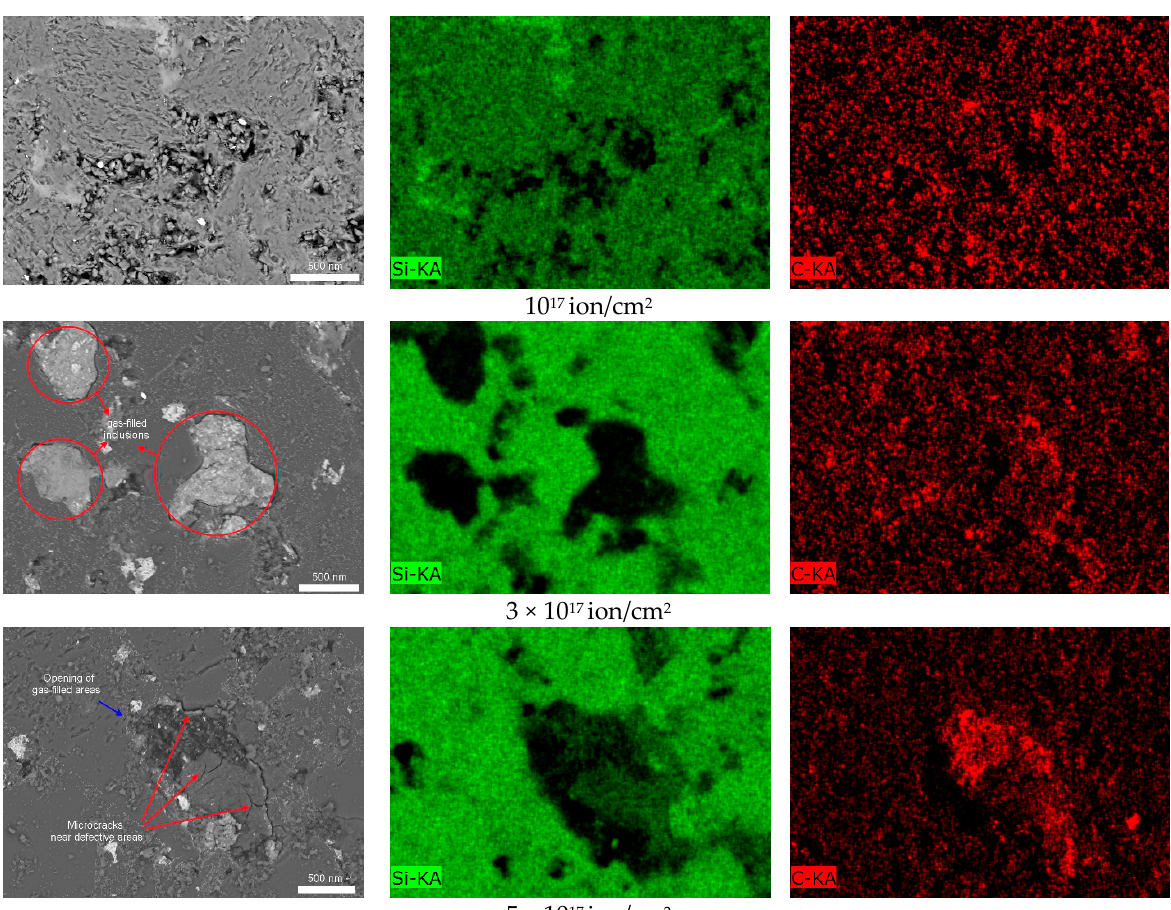
Figure 13. The results of mapping the distribution of elements near defective inclusions on the surface of samples irradiated with the fluence of 10 17 –5 × 10 17 ion/cm 2.